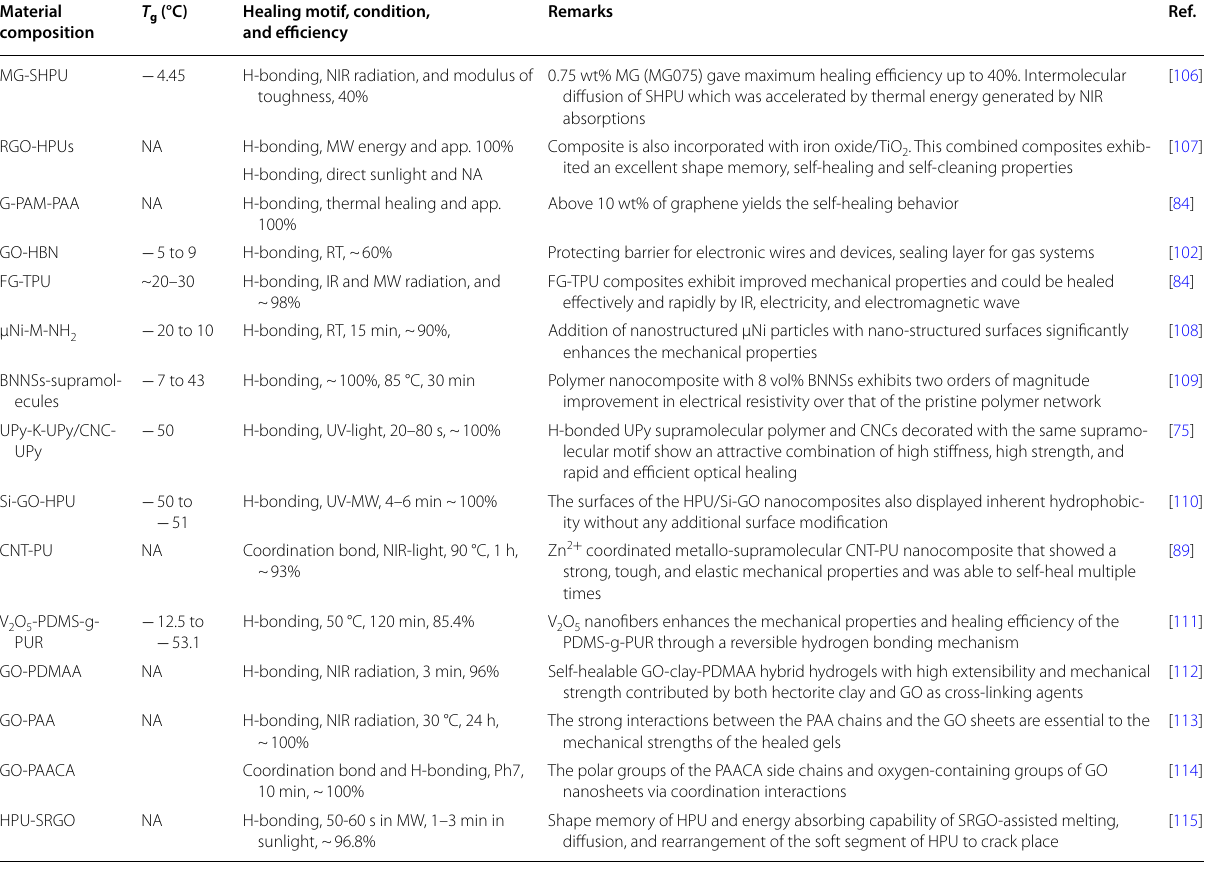
Table 2 Summary of recent self‑healing systems based on supramolecular hydrogen bonds and metal‑coordination crosslinking: mechanical characteristics, self‑healing‑conditions and